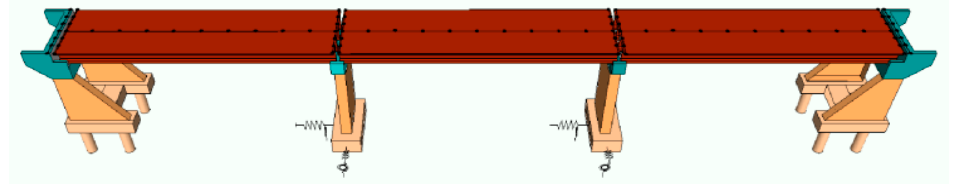
Figure 7. Bridge model.